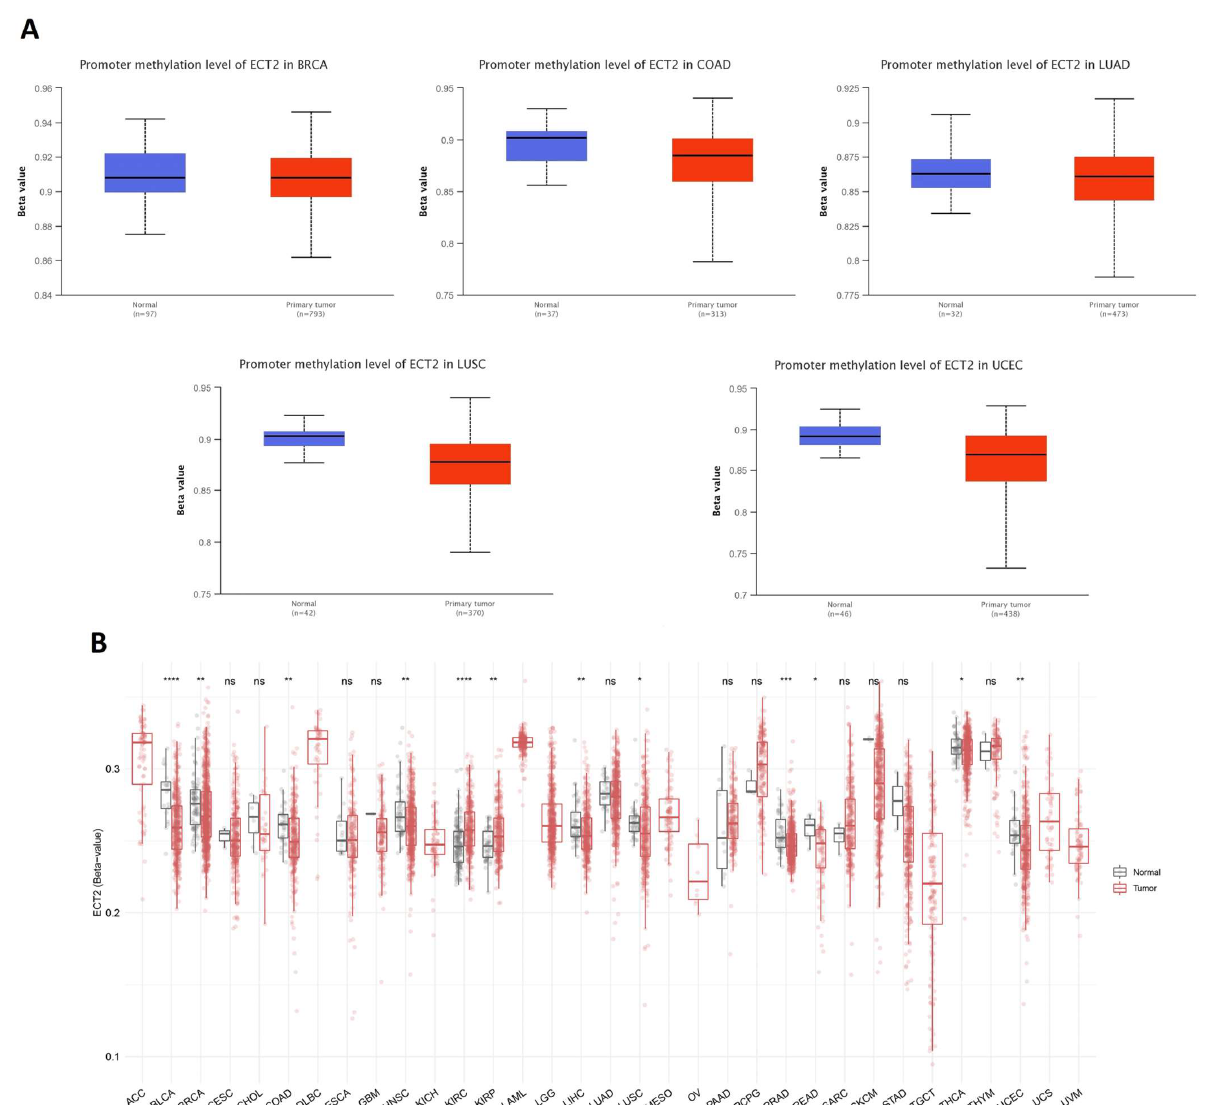
Figure 6. Differential methylation analysis of ECT2 in tumor samples versus normal ones. ( A ) Tumors experienced higher methylation in the ECT2 promoter region in normal samples versus tumors as assessed by UALCAN analysis. ( B ) Analysis of CpG-aggregated methylation of ECT2 in a list of human tumors. ns: p > 0.05; *: p <= 0.05; **: p <= 0.01; ***: p <= 0.001; ****: p <= 0.0001.